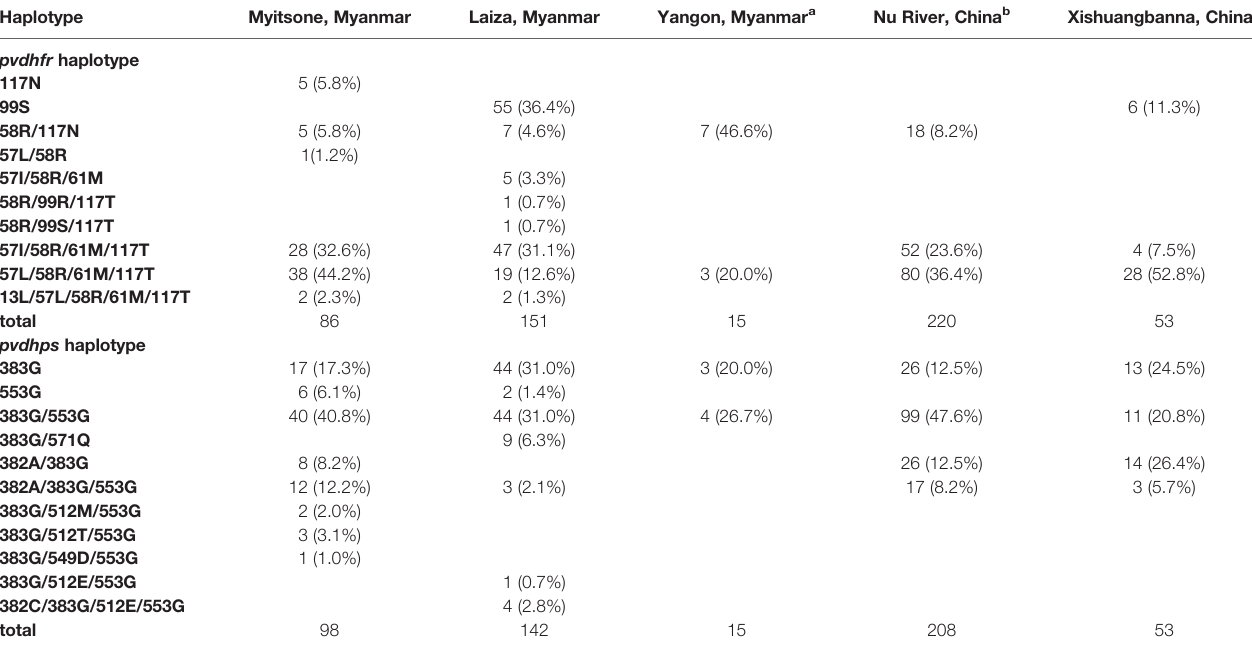
TABLE 6 | Distribution of major haplotypes of the pvdhfr and pvdhps genes in P. vivax from different regions in Myanmar and Yunnan, China. Haplotype